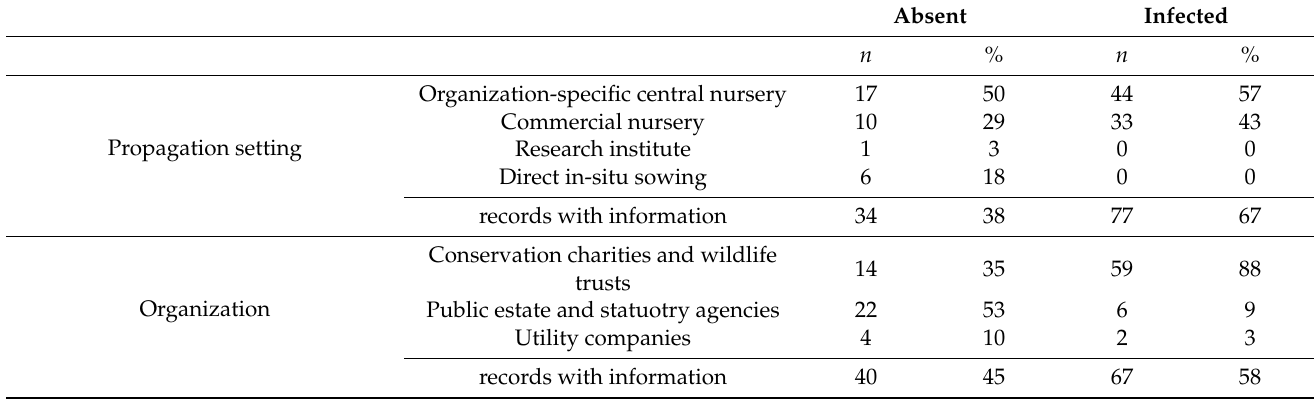
Table 3. Propagation setting of planting material and type of organization overseeing the planting project according to categories detailed on Table 1. The number (n) and percentage (%) of planting records with associated information per category are shown for planting events occurring in the buffer zone of absence (41 monads, 89 planting events) and infected (25 monads, 115 planting events)